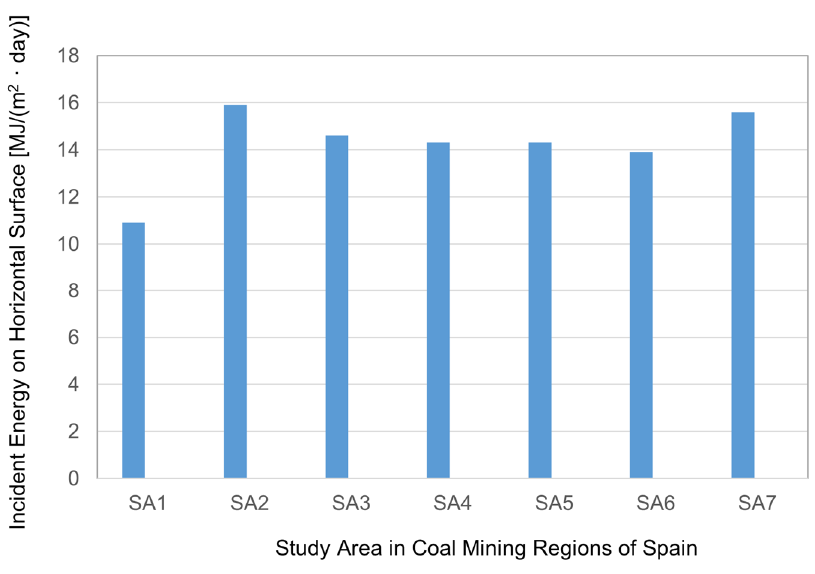
Figure 5. Availability of solar resource in the study area by sector.